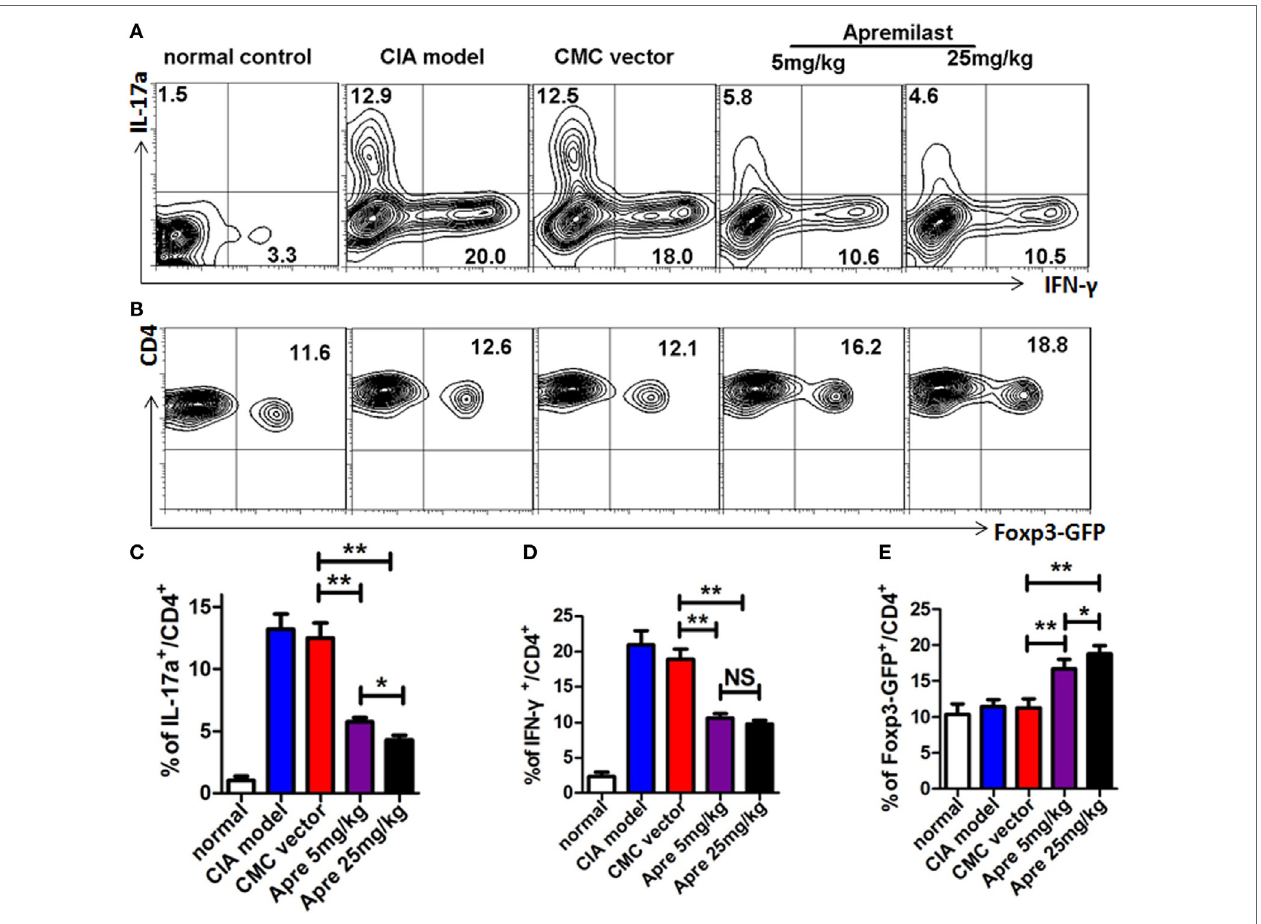
FigUre 4 | Apremilast reduced arthritis through suppression of Th1 and Th17 cells and enhancement of regulatory T cell differentiation. Cells were isolated from the draining lymph nodes of arthritic mice on day 56 after type II collagen immunization in Apremilast (5 or 25 mg/kg), CMC vehicle alone, collagen- induced arthritis (CIA) model, and normal groups. The expression of IL-17a, IFN- γ (a) , and Foxp3 + -GFP (B) on CD4 + T cells were measured in draining lymph node cells by flow cytometry. The summary data are shown in the lower panel (c–e) . The data indicate the mean ± SEM of five mice per group from two independent experiments (* p < 0.05, ** p < 0.01). Data were analyzed using the one-way ANOVA for comparison among multiple groups, followed by Turkey’s